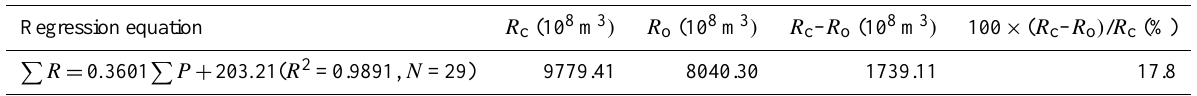
Table 4. Linear regression equations between cumulative streamflow and cumulative precipitation for the period before the transition years in the MRYR basin.